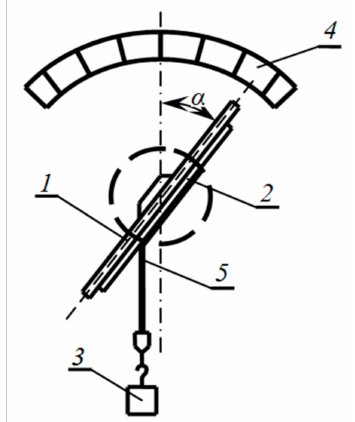
Figure 7. Angular adhesion meter by Krotova and Deryagin [4]. 1—Plate, 2—prototype (substrate), 3—weight, 4—goniometer scale, 5—film peeled o ff from the